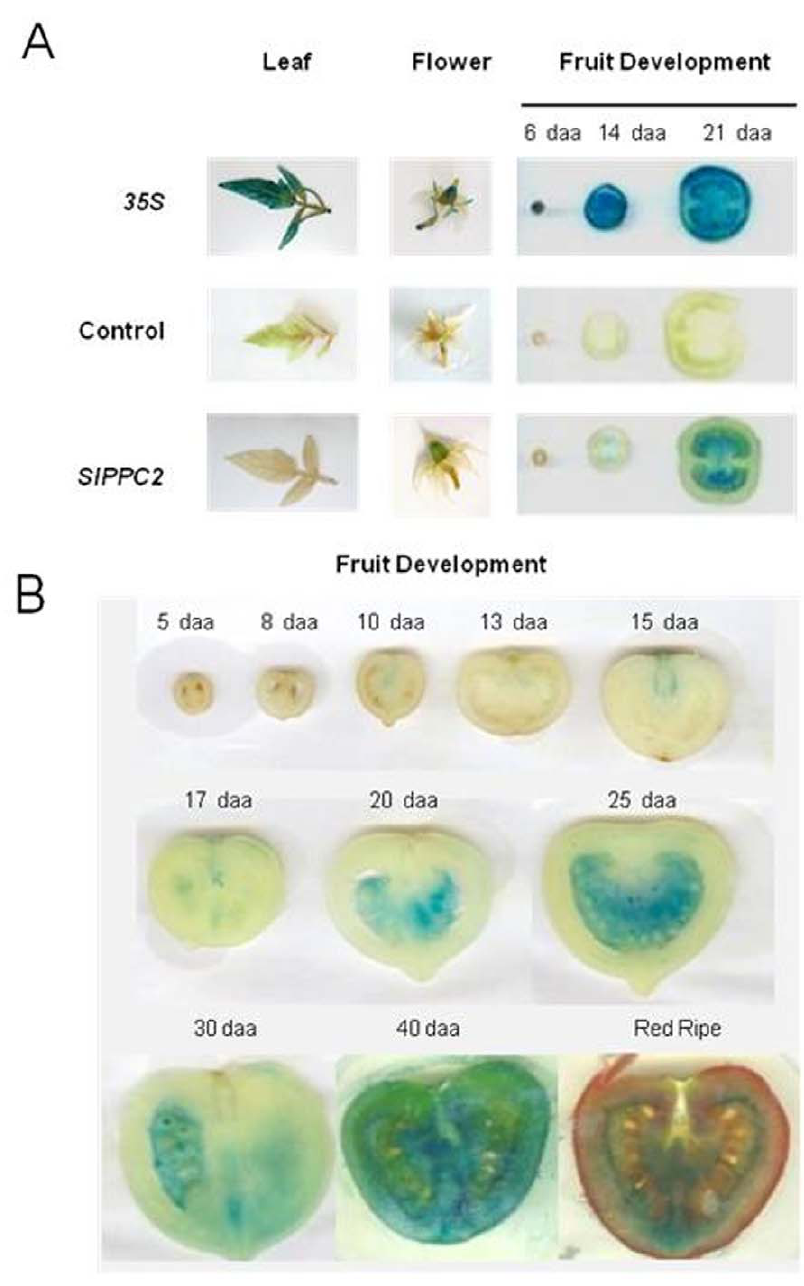
Figure 2. GUS activity in tomato (cv. «Ferum») stably transformed with SlPPC2 promoter:GUS transgenes. (A) Representative images of GUS activity in seedlings, leaf, flower and 6, 14 and 21 days after anthesis (daa) tomato fruit with the 35S:GUS and SlPPC2 promoter:GUS constructs. (B) Representative images of GUS activity in «Ferum» fruits at the various stages of fruit development (daa) as indicated.